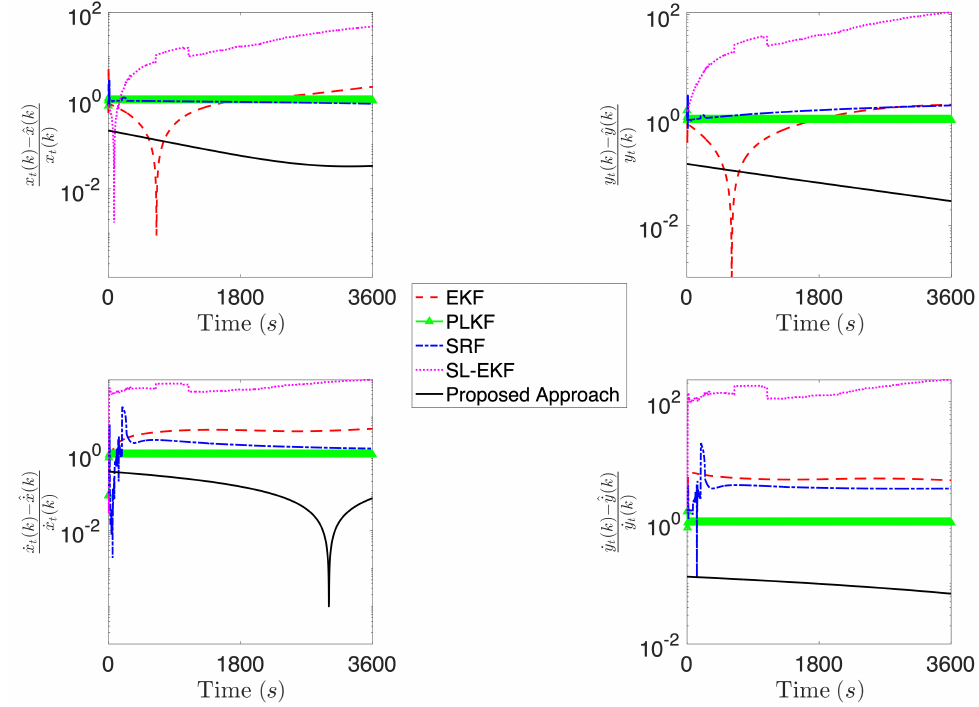
Figure 10. Comparison of the proposed approach against EKF, PLKF, SRF and SL-EKF, con- sidering a scenario where the methods compared with the proposed one are initialized with (cid:0) (cid:1) 0 6 ,diag ( ψ ) 2 and Σ 0 | 0 = diag ( ψ ) 2 (cid:98) x 0 | 0 ∼ N